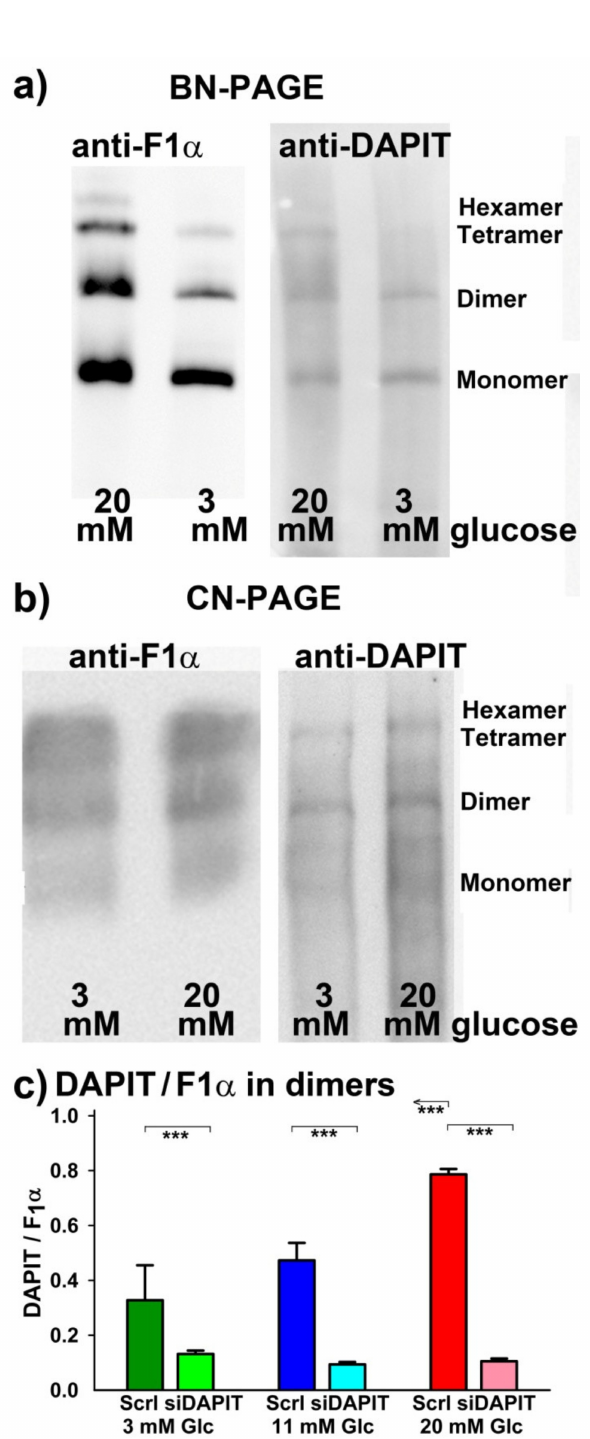
Figure 10. Rough estimations of DAPIT to F 1 α stoichiometry in ATP synthase dimers. ( a ) Exemplar BN-PAGE shows missing hexamers and majority of tetramers at 3-mM glucose; ( b ) CN-PAGE immunostained with anti-F 1 α or anti-DAPIT antibody as indicated; ( c ) DAPIT / F 1 α stoichiometry was estimated from N = 3 CN-PAGEs separating ATP synthase monomers / oligomers after dual western blotting. *** p < 0.001 ( n = 3), for significant di ff erences of DAPIT-silenced vs. INS-1E Scrl